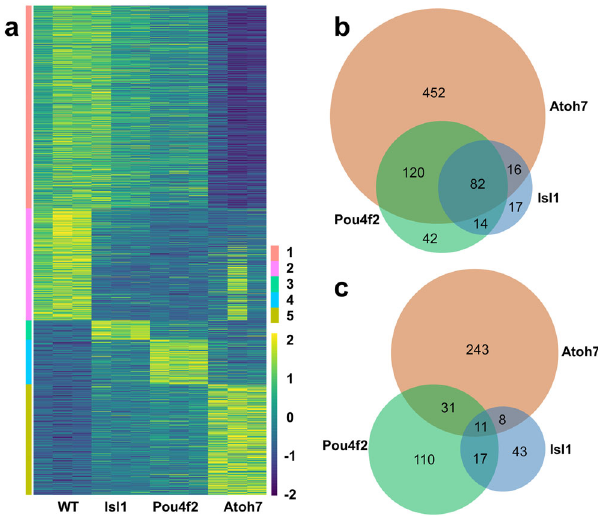
Fig. 1 Conventional RNA-seq identi fi es differentially expressed genes (DEGs) in E14.5 Atoh7 -null, Pou4f2 -null, and Isl1 -null retinas. a Clustering of all DEGs across all four genotypes based on Z scores indicates the Atoh7 - null retina is least similar, whereas the Isl1 -null retina is most similar to the wild-type retina. Each genotype has three replicate samples. The genes were divided into fi ve groups (1 – 5) based on how they are affected in the three mutants. The color scale represents cross-sample Z scores for individual genes (rows). Source data are from Supplementary Data 2. b A Venn-diagram showing the overlaps of downregulated genes in all three mutant retinas. c A Venn-diagram showing the overlaps of upregulated genes in the three mutant retinas. Source data for ( b , c ) are